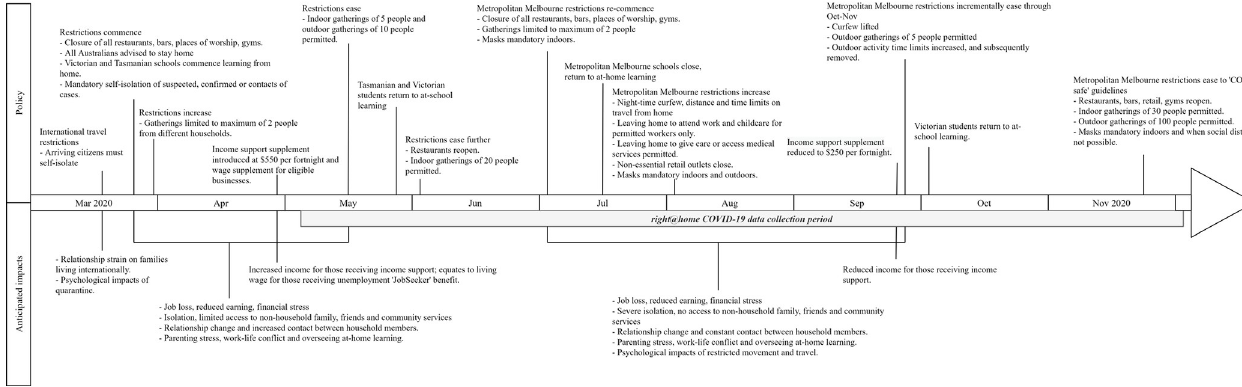
Fig 1. Timeline of COVID-19 policy implementation and impacts on